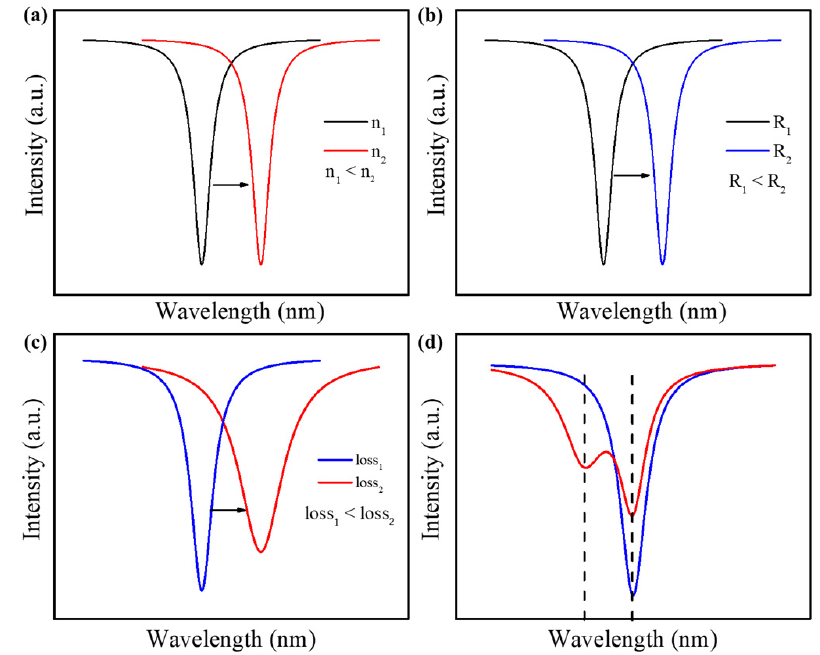
Figure 4. Sensing mechanism of the microbubble resonators: ( a ) wavelength shift with RI; ( b ) wave- length shift with microbubble radius; ( c ) mode-broadening; ( d ) mode-splitting.